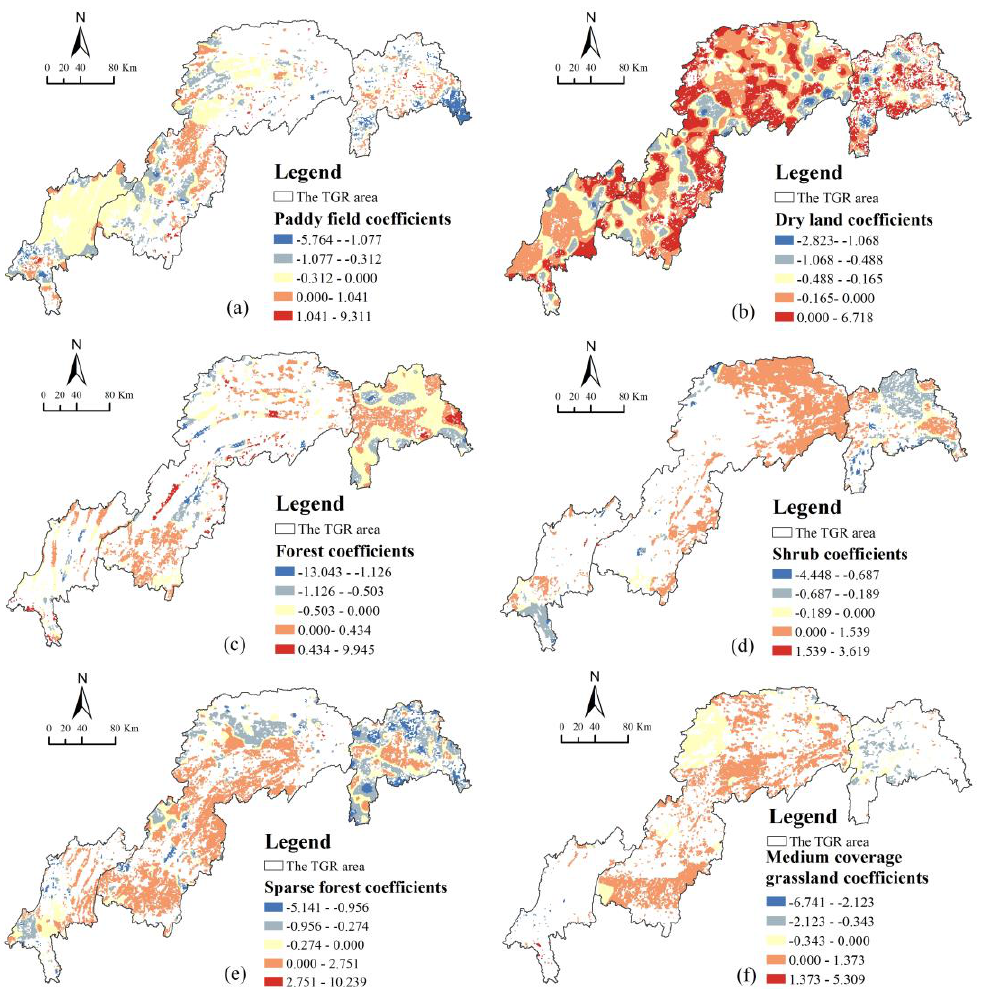
Figure 11. Spatial distribution of regression coefficients of MGWR model from 2000 to 2020 (( a ) paddy field, ( b ) dry land, ( c ) forest land, ( d ) shrubland, ( e ) sparse forest land, ( f ) medium-coverage grassland. Also the white area is the background).